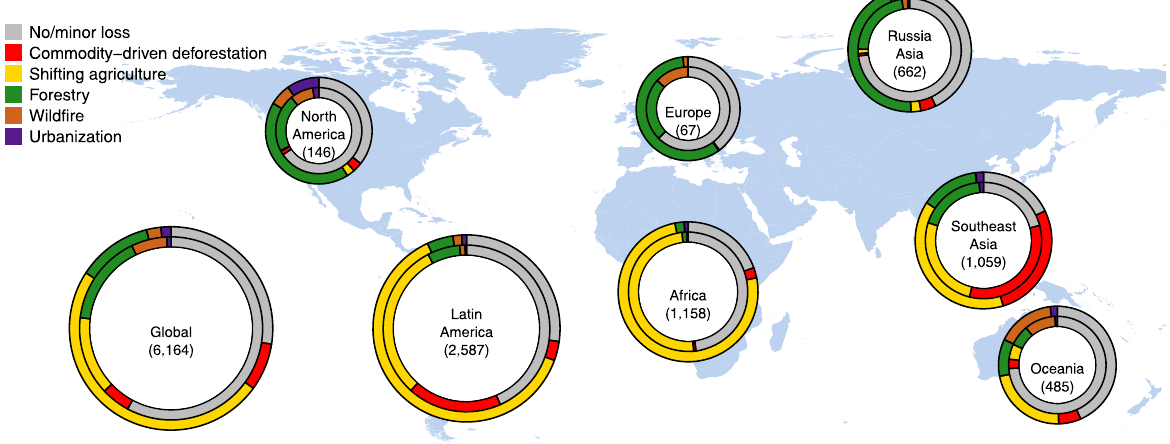
Fig. 1 Comparison between map-based original driver proportions (inner ring) and driver proportions within species ranges (outer ring). Values in parentheses are the numbers of threatened species